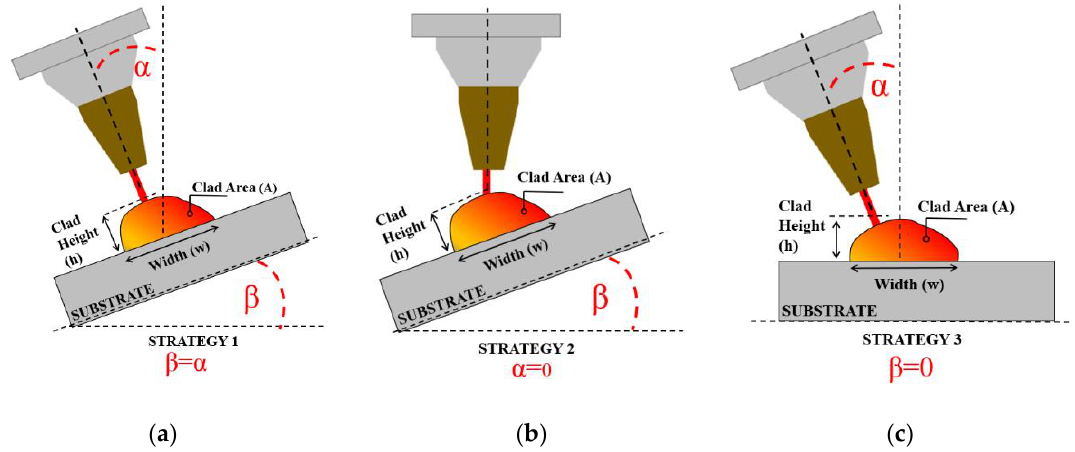
Figure 3. Strategies for the analysis of the effect of the head tilting and non-perpendicular deposition: ( a ) Strategy 1 ( α = β ); ( b ) Strategy 2 ( α = 0); ( c ) Strategy 3 ( β = 0).